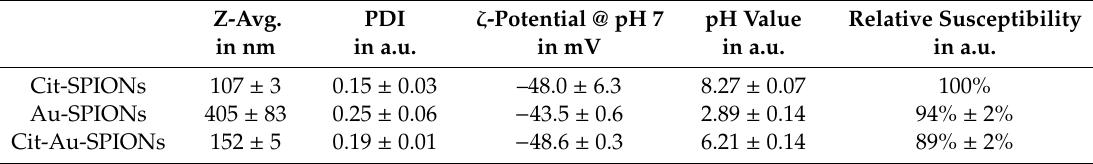
Table 1. Comparison of the basic parameters of Cit-SPIONs, Au-SPIONs and Cit-Au-SPIONs. Z-Avg. PDI ζ -Potential @ pH 7 pH Value Relative Susceptibility in nm in a.u. in mV in a.u. in a.u.